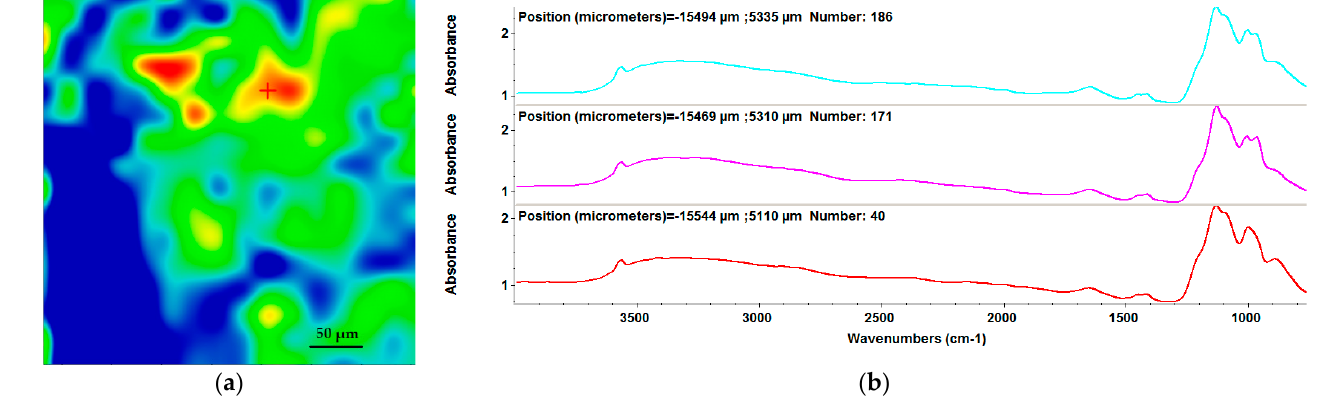
Figure 3. IR map ( a ) and corresponding FT-IR spectra ( b ) assigned to the phosphate group for the drop-cast reference material.